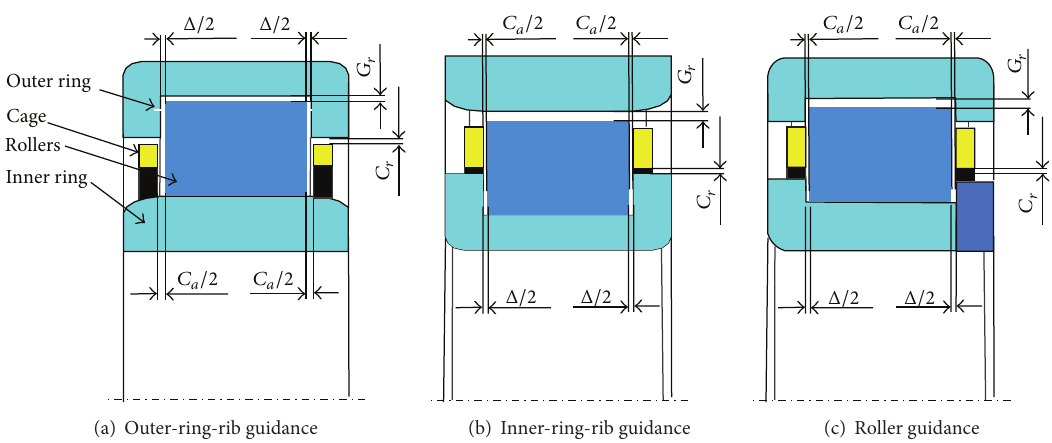
Figure 1: Cage guidance in cylindrical roller